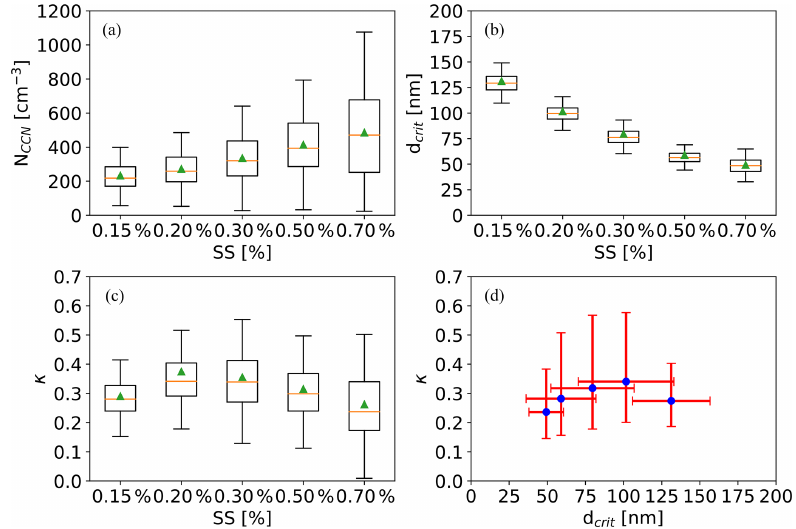
Figure 5. Boxplots of N CCN (a) , d crit (b) and κ (c) at supersaturations (SS) from 0.15% to 0.70% based on all available data. Whiskers show the 90th and 10th percentiles. Green solid triangles show the mean values. (d) κ as a function of d crit . Error bars of d crit show 1 standard deviation. Error bars of κ show 1 geometric standard